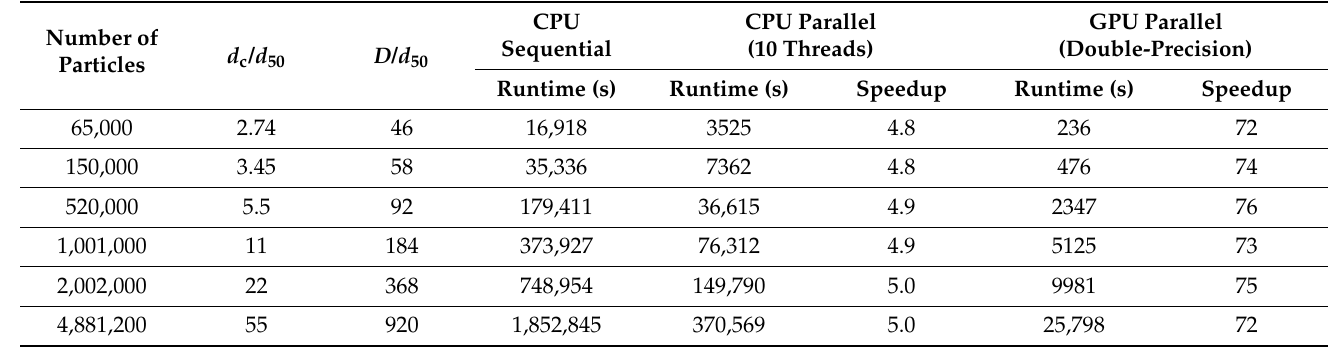
Table 3. Speedups of CPU and GPU parallel simulations in cone penetration test cases (10,000 incremental steps).